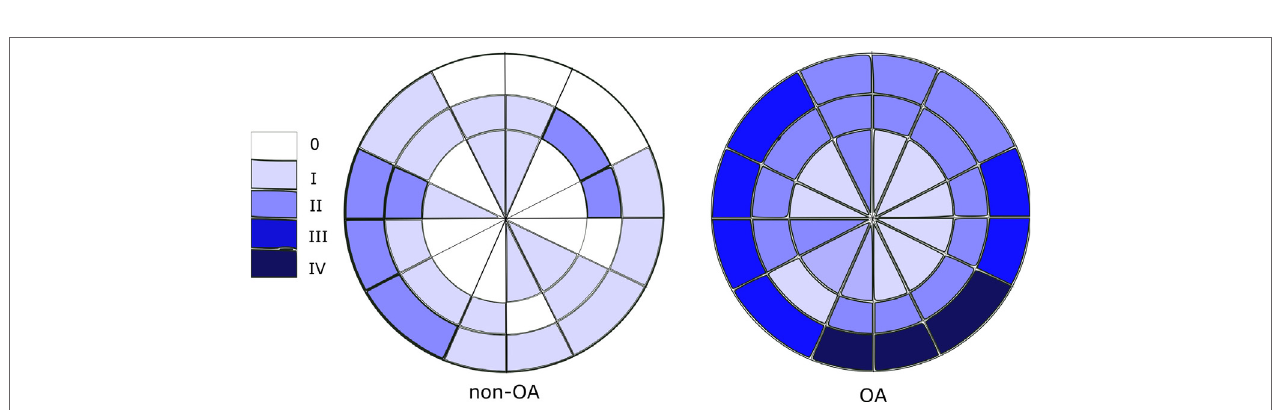
FigUre 3 | Outerbridge scoring (median score) of OA and non-OA samples shows minimal cartilage degeneration in non-OA samples and severe cartilage degeneration in 25% of regions of interest in OA samples.